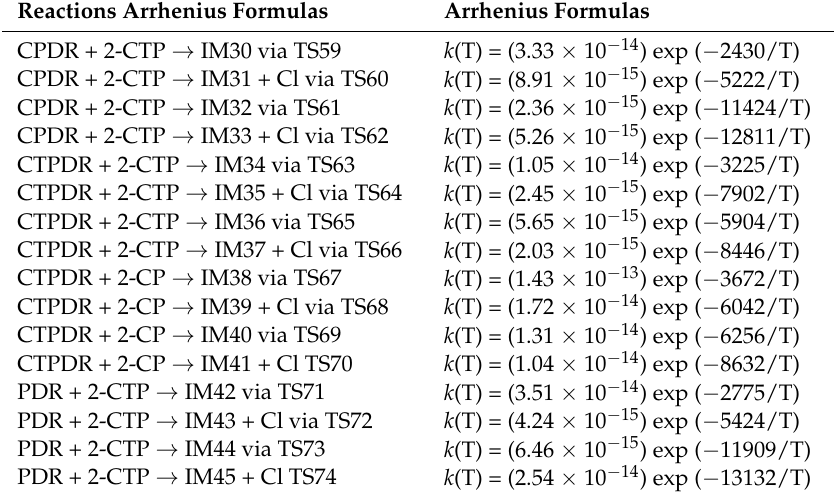
Table 2. Arrhenius formulas for pre-PCDT/DF formation routes from the cross-condensation reactions of 2-C(T)P with C(T)PDR and (T)PDR over the temperature range of 600–1200 K (unit is cm 3 molecule − 1 s − 1